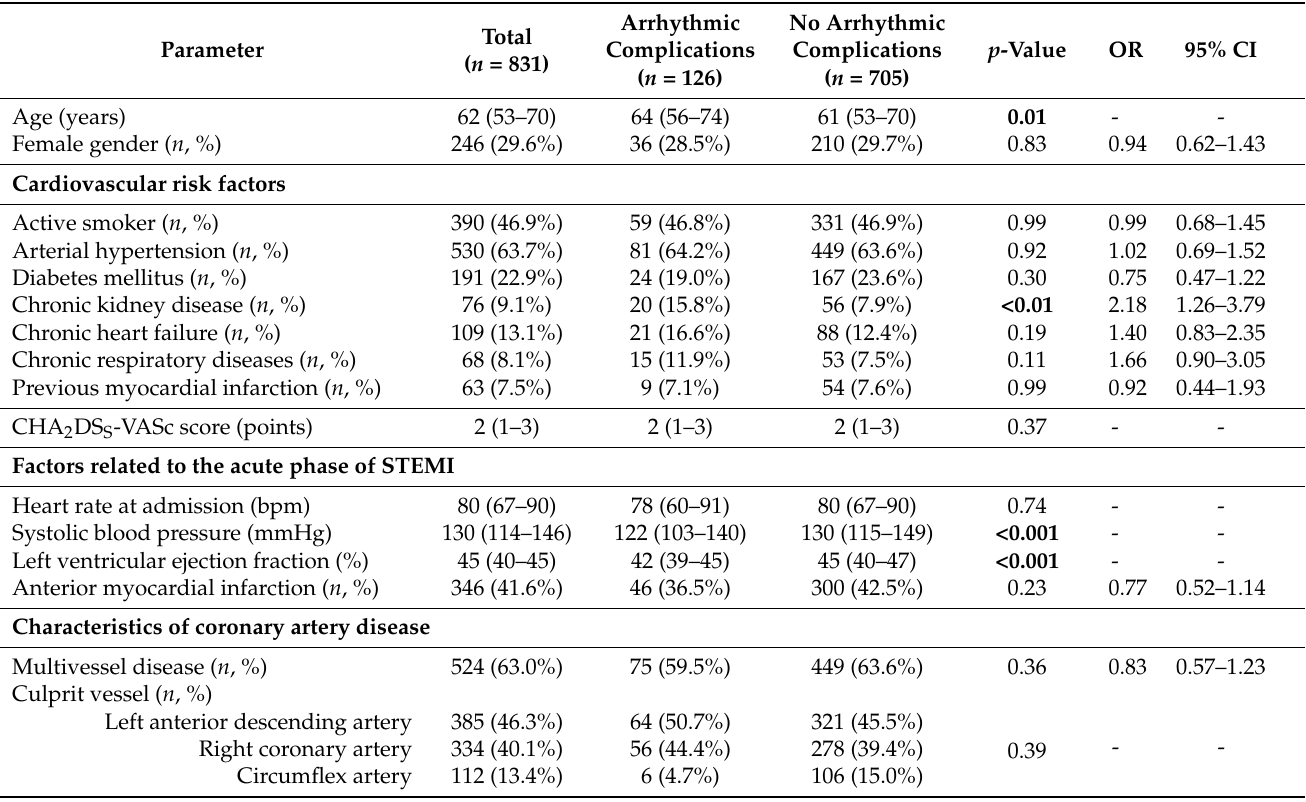
Table 1. Characteristics of patients with and without ST-segment elevation myocardial-infarction- related arrhythmic